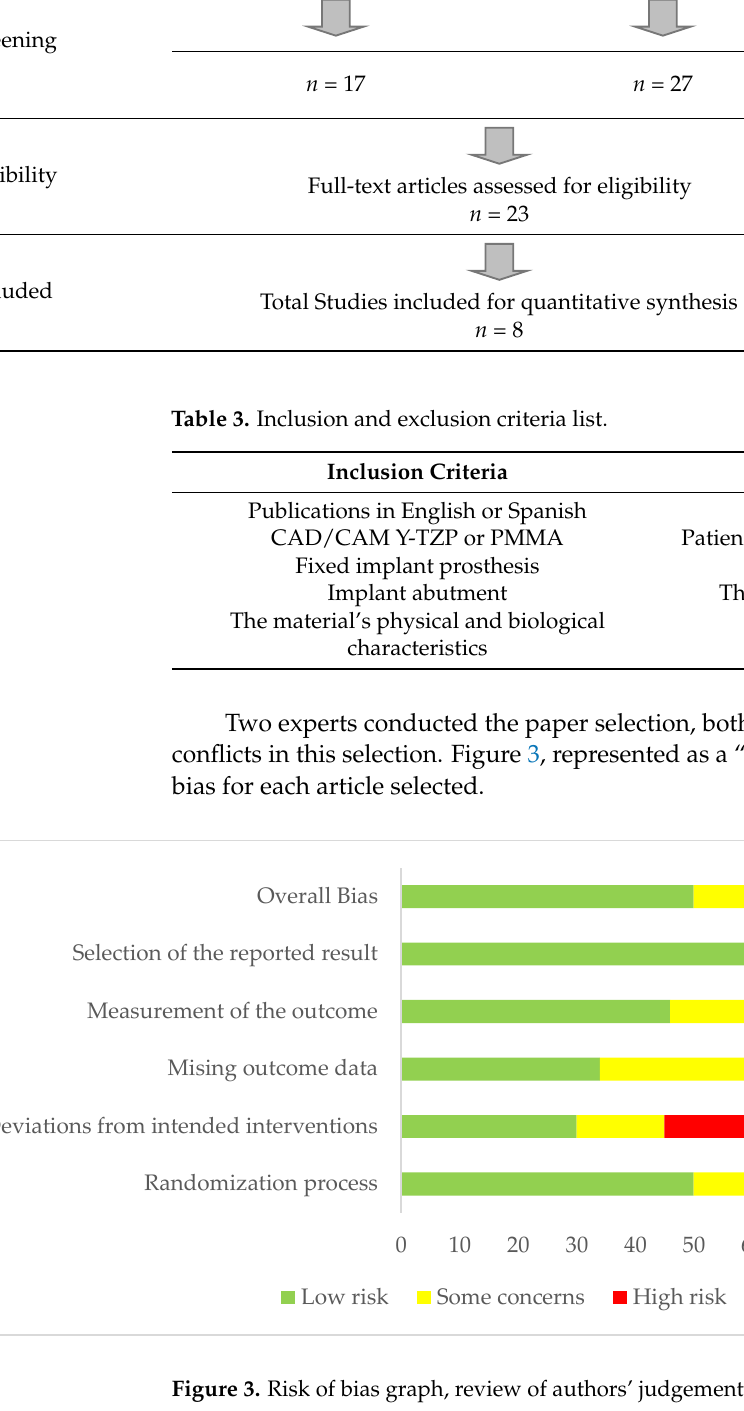
Table 2. Search strategy and results of identification, screening for eligibility, and inclusion of pub- lications considered for review.